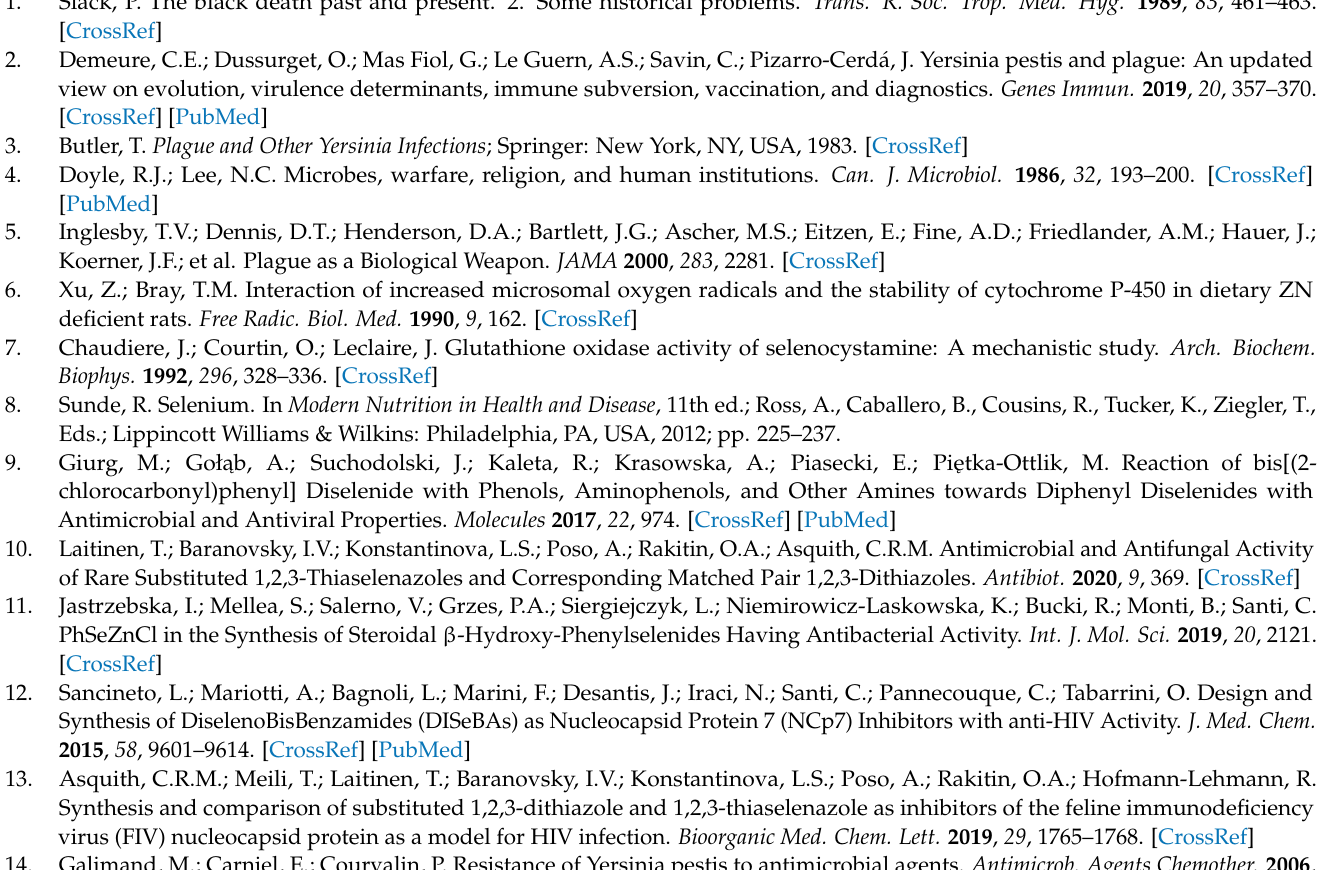
Figure S2: Discovered Motifs from Peptide Sequences using MEME (https://memesuite.org/meme/ tools/meme, accessed on 20 May 2021); Figure S3: Frequency of Amino Acids from Peptide Sequences using MEME (https://memesuite.org/meme/tools/meme, accessed on 20 May 2021); Figure S4: Settings Used for Analysis of Peptides Using MEME (https://memesuite.org/meme/tools/meme, accessed on 20 May